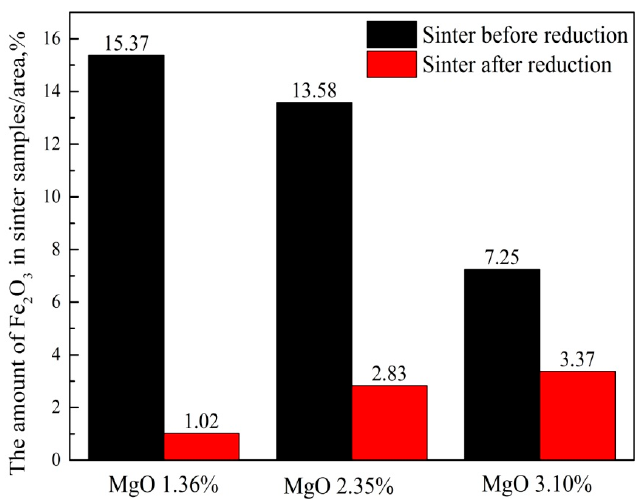
Figure 8. The amount of Fe 2 O 3 in sinter samples containing various levels of MgO.